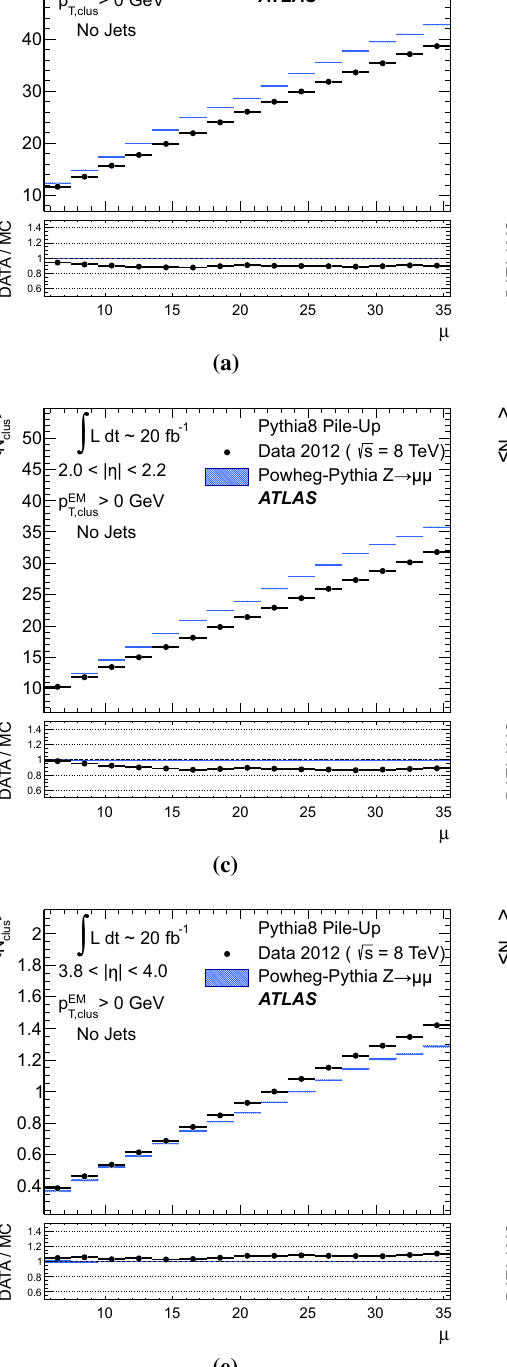
> 1GeV. The corresponding ratio of data counting clusters with p EM T , clus to MC simulations is shown below each plot. All results are obtained from a 2012 Z → μμ sample without jets with p T > 20GeV in data and MC simulations. The narrow shaded bands indicate the statistical uncertainties associated with the results from MC simulations for the mean values and the